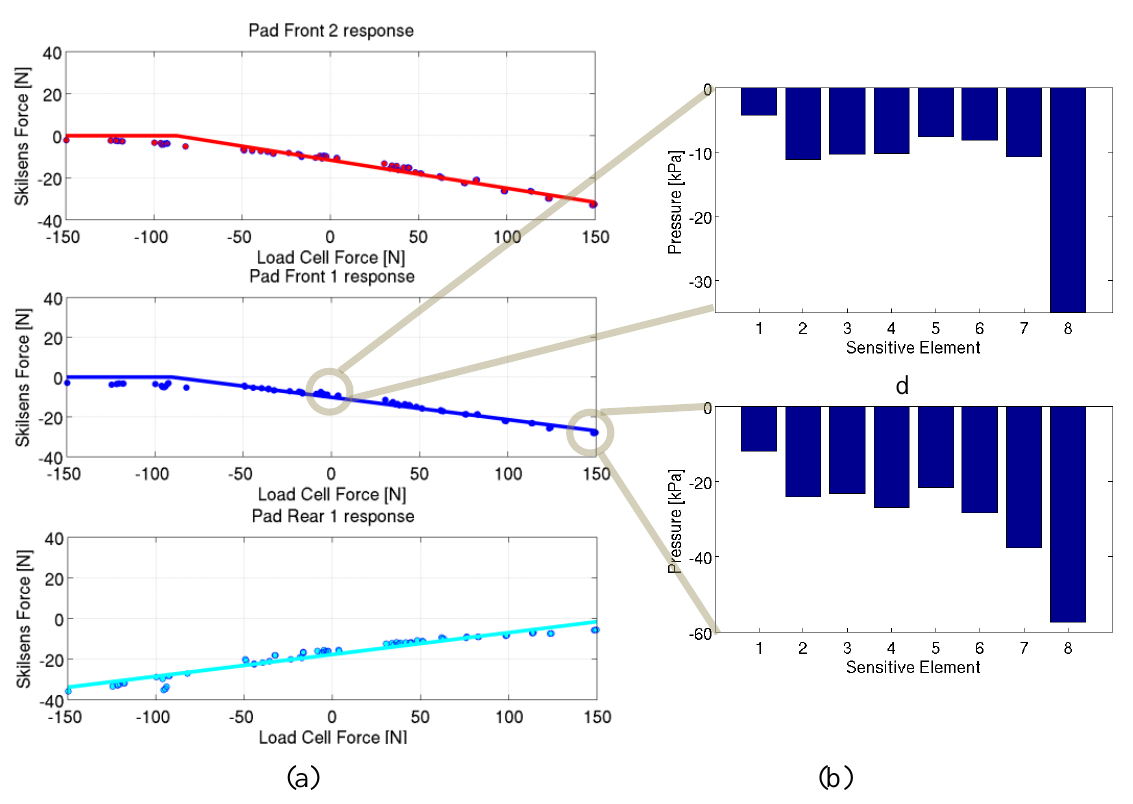
Figure 10. Static characterization results: (a) Force on the three pads, compared with the force recorded by the load cell. (b) Pressure distribution on the sensor at zero and peak interaction. Channels are ordered from top (1) to bottom (8).